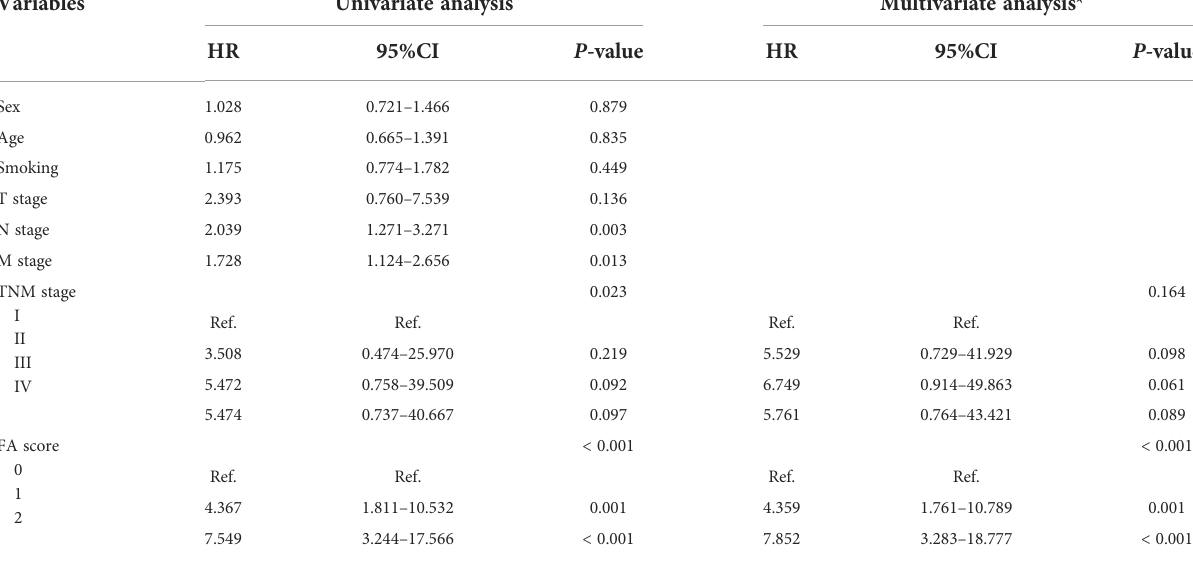
TABLE 3 Univariate and multivariate analysis of clinical characteristics related to OS.